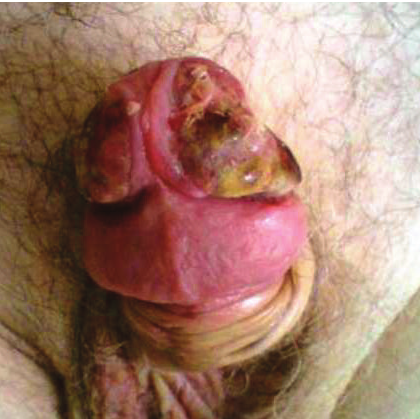
Figure 1: Dorsal view of the necrotic ulcer on the glans penis.